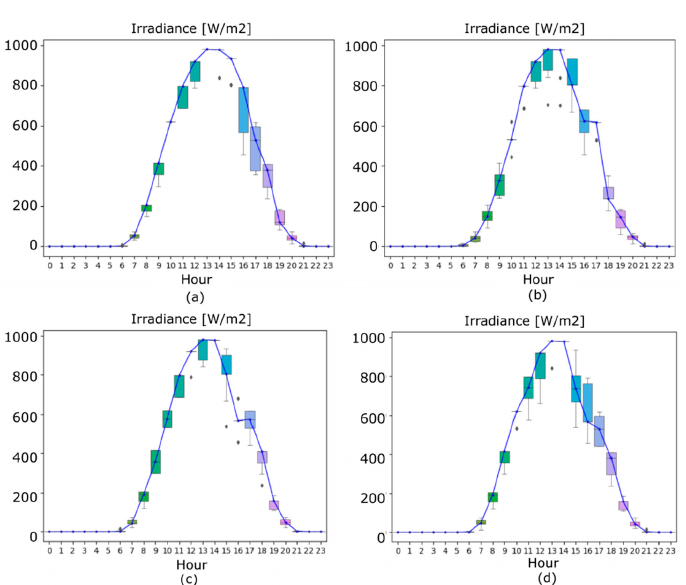
Figure 9. Median scenarios (blue) with box-whisker plot for scenarios generated for July using 𝑛 (cid:3020) = 1000 , 𝑛 (cid:3017) = 10 , and 𝑛 (cid:3019) = 7 without outlier removal and varying the type of metric : ℓ (cid:2869) -Norm ( a ), ℓ (cid:2870) -Norm ( b ), ℓ (cid:2872) -Norm ( c ), and ℓ (cid:2998) -Norm ( d ).